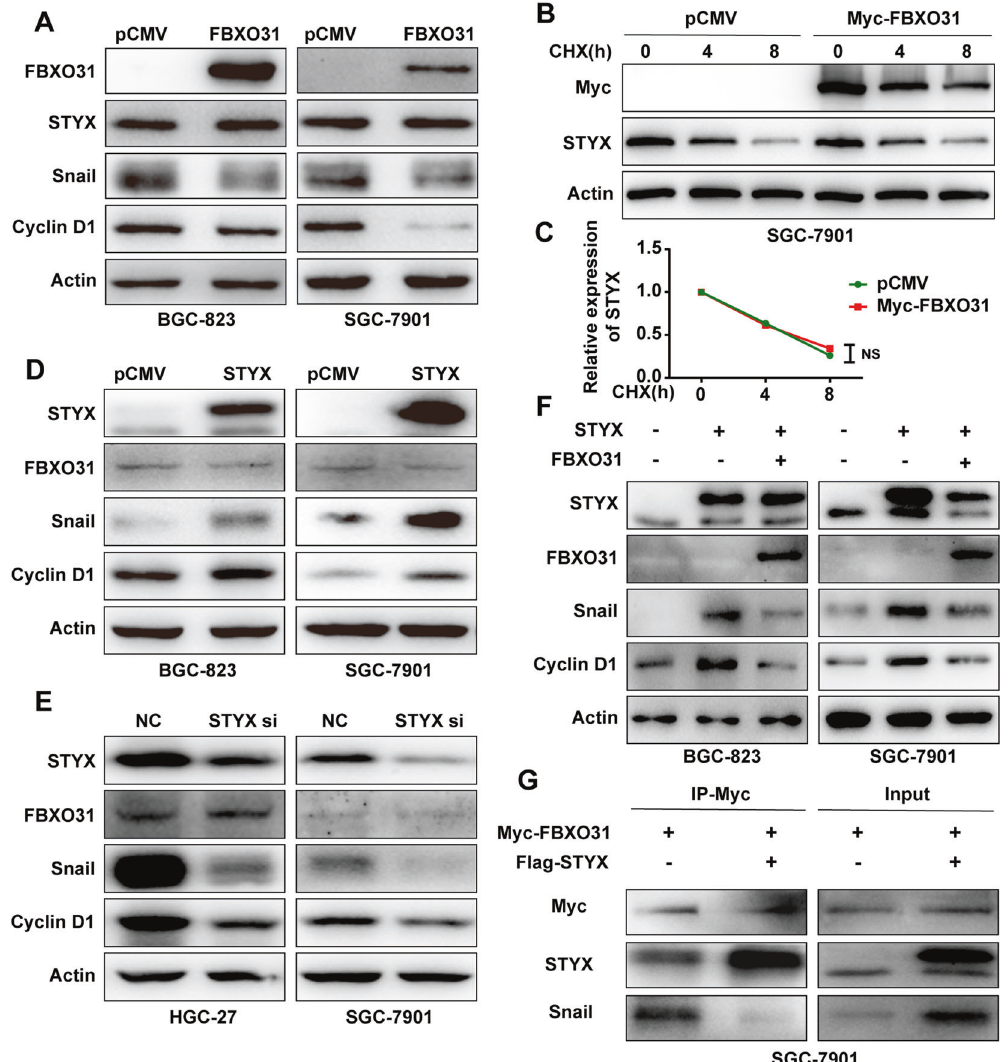
Fig. 6 STYX in fl uences the progression of GC by interacting with FBXO31. A Western blot was used to detect STYX, Snail1 and CyclinD1 in GC cells transfected with pCMV or FBXO31. B The GC cells were transfected with pCMV and FBXO31 expression vector. Then the transfected cells were treated with CHX at indicated time. Western blot analysis of the expression of STYX in the treated GC cells. C STYX expression levels were quanti fi ed by measuring the band intensities using “ ImageJ ” software. The values were normalized to β -actin. D Western blot was used to detect FBXO31, Snail1, and CyclinD1 in GC cells transfected with STYX expression vector. E Western blot was used to detect FBXO31, Snail1, and CyclinD1 in GC cells transfected with STYX siRNA. F Western blot was used to detect Snail1 and CyclinD1 in GC cells co-transfected with STYX and FBXO31. G Myc-FBXO31 and Flag-STYX were co-transfected into SGC-7901 cells for 48 h. Co-immunoprecipitation was performed with Myc antibody to detect STYX or Snail1